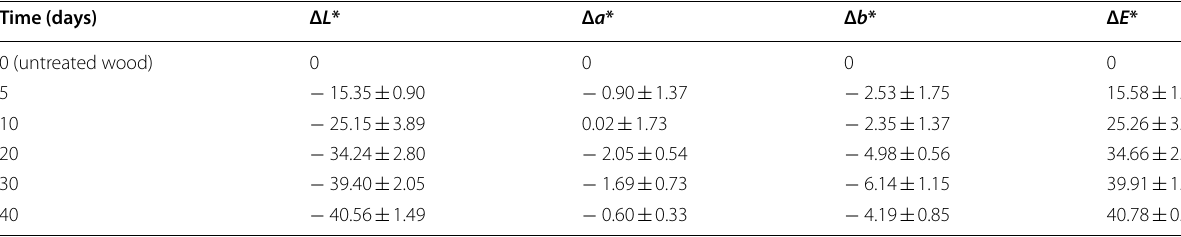
Table 2 Wood color dyed with fungi in different days Time (days) Δ L